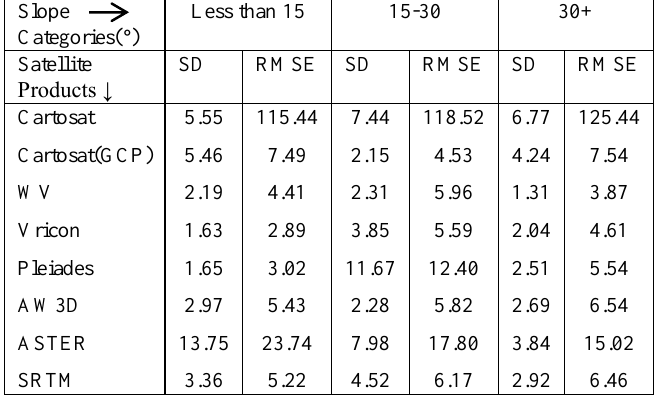
Table-4: Standard deviation and RMSE in planimetric direction in different slope categories.